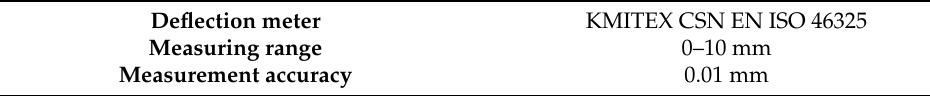
Table 1. Parameters of deflection meter Kmitex CSN EN ISO 46325.